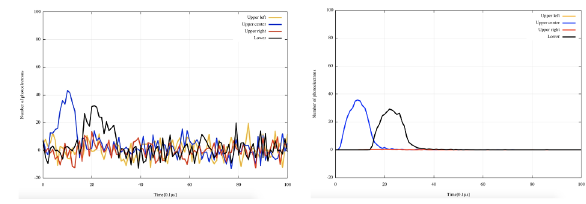
Figure 7. Observed waveform by CRAFFT detector (Left) and simulated waveform (Right) to be compared to observed one.